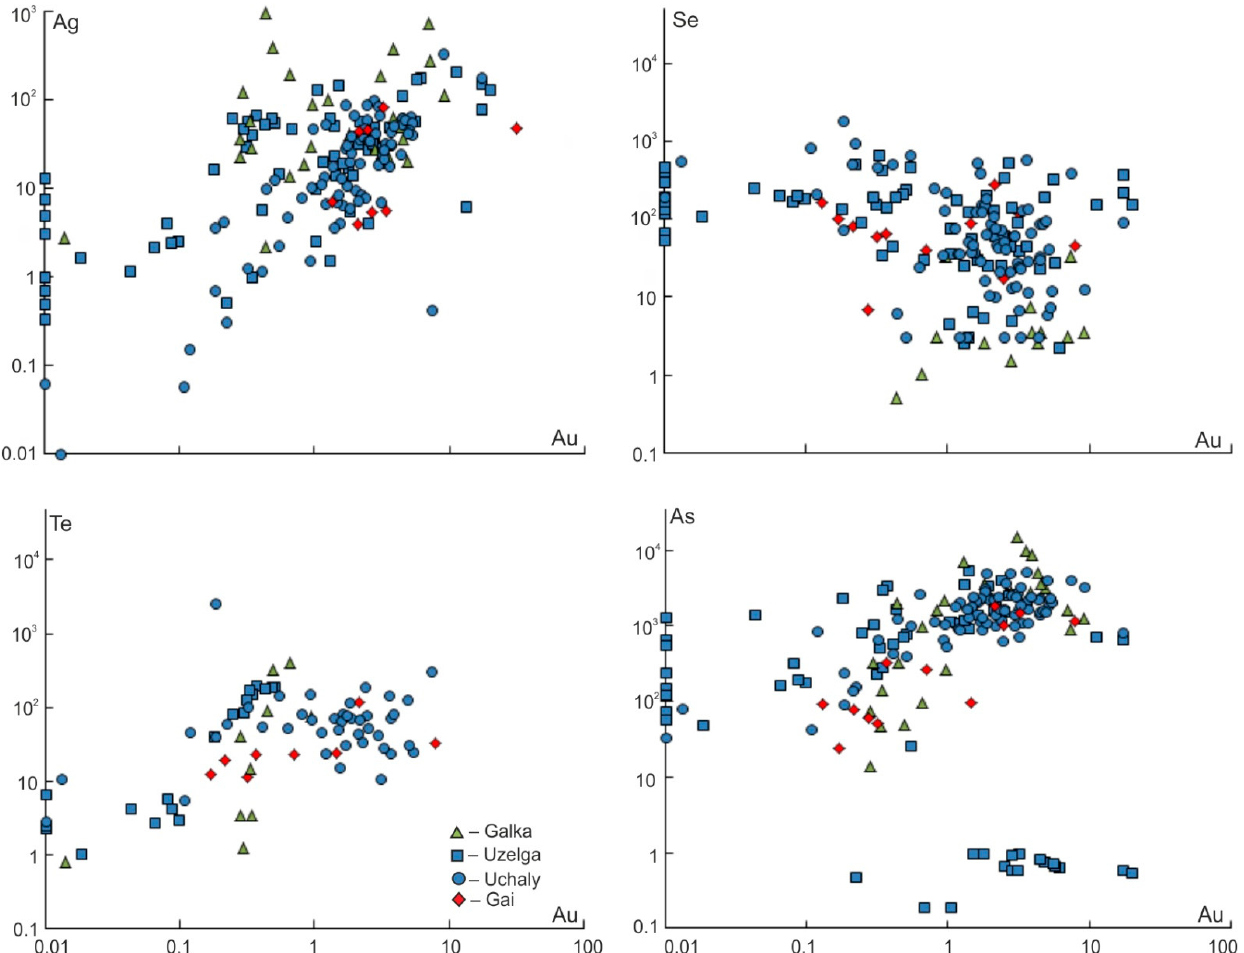
Figure 23. Binary diagrams of the contents of Au, Ag, Se, Te and As (ppm) in pyrite of the VMS deposits of the Urals according to the LA-ICPMS data. Table 20. Summary data on contents of Au and Ag in ore minerals of VMS deposits according to LA-ICP-MS analysis. Table 21. Contents of Au, Ag and some impurities in chalcopyrite of VMS deposits according to LA-ICP-MS data Deposit